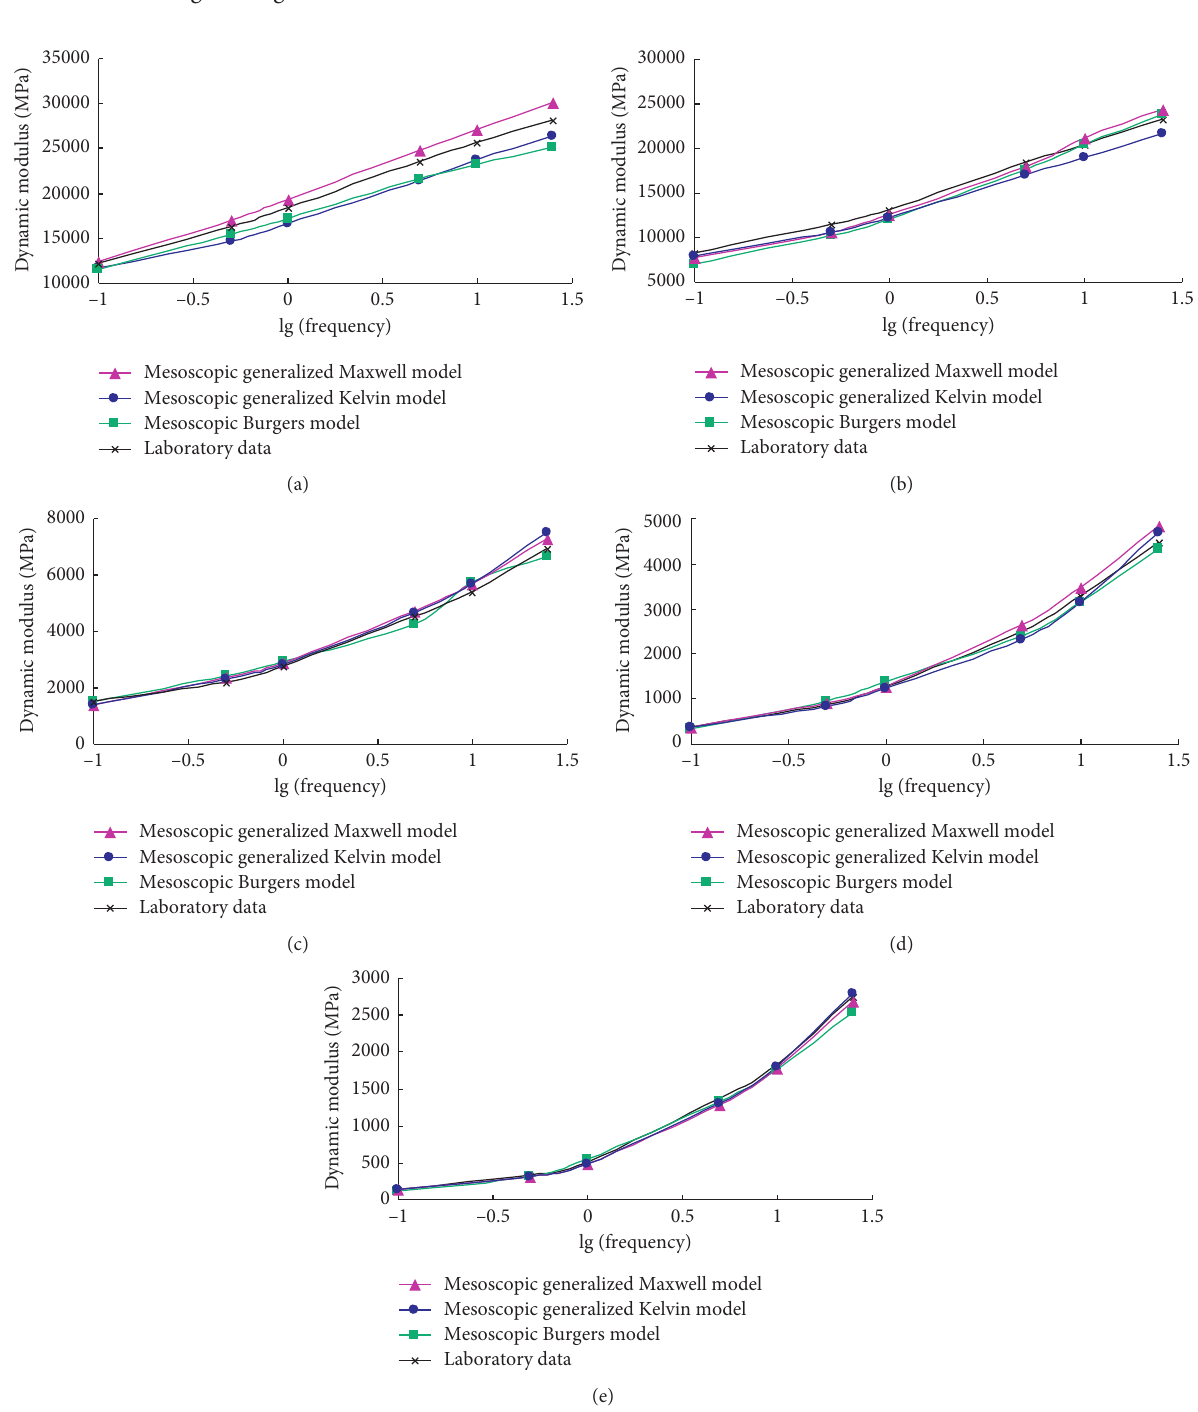
Figure 10: Laboratory data and simulation results of dynamic modulus. (a) − 6 ° C. (b) 4 ° C. (c) 16 ° C. (d) 27 ° C. (e) 38 °